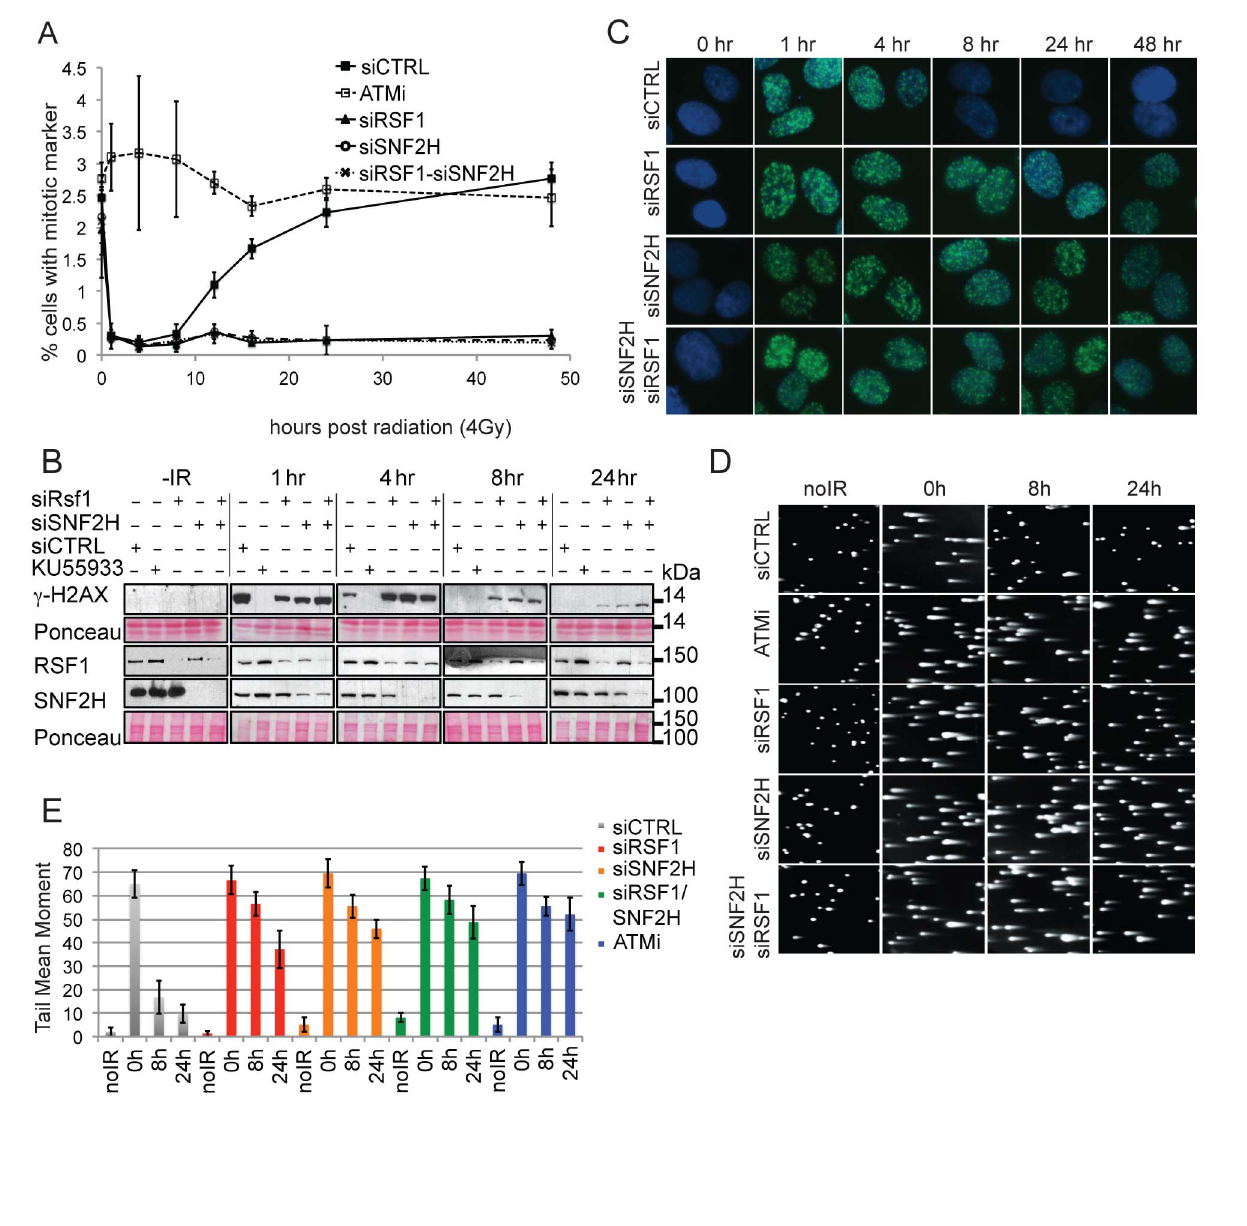
Figure 3. RSF1 promotes efficient DSB repair. (A) G2/M checkpoint analysis in U2OS cells. Inhibition of ATM or specific siRNA depletions are as indicated. Cells positive for the mitotic marker were followed for 48 h after irradiation. (B) Western blot analysis of c -H2AX phosphorylation after IR (4 Gy) over 24 h in U2OS cells treated as indicated. The extent of knockdown is indicated in the RSF1 and SNF2H blots. (C) Immunofluorescence showing c -H2AX IRIF formation and persistence in U2OS cells over 48 h postradiation (4 Gy) and treated with the indicated siRNAs. (D) Neutral comet assay showing the repair of fragmented DNA induced by 2 Gy of IR in U2OS cells treated either with an ATM inhibitor (KU55933) or with the indicated siRNAs. (E) Quantification of tail moments represented in the neutral comet assay shown in Figure 3D. Error bars indicate standard error of the mean (SEM) from three independent experiments.